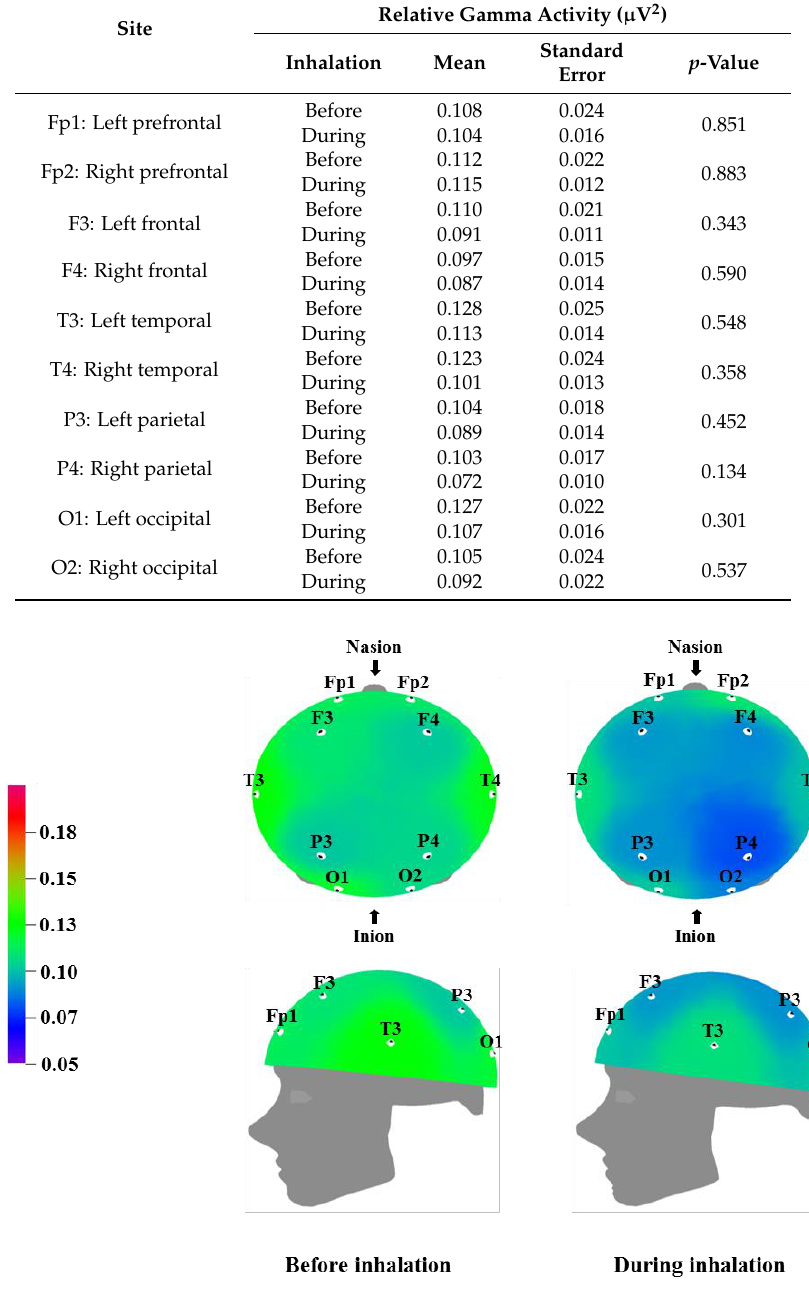
Figure 4. Relative gamma wave intensity between before and during inhalation of VOCs from C. indicum Linné.